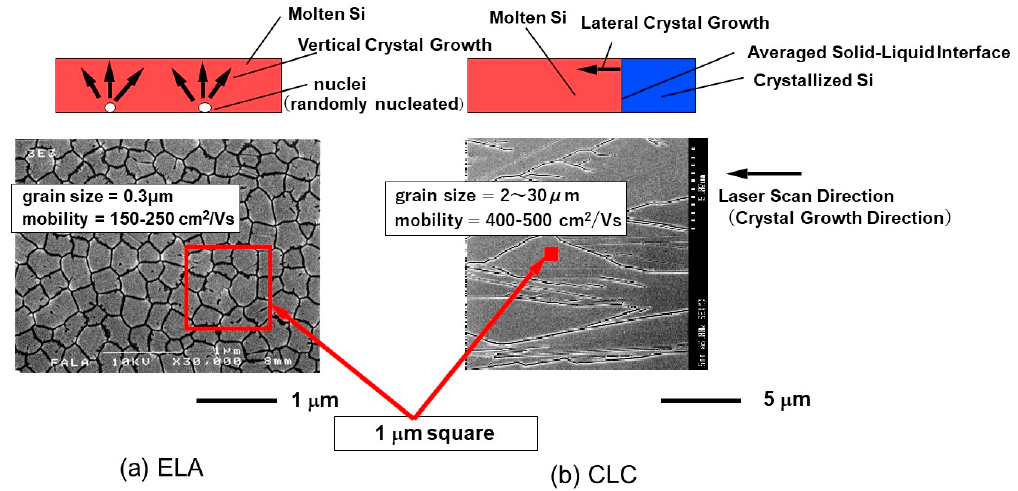
Figure 3. SEM pictures after the delineation of grain boundaries by Secco etching. Crystal growth directions and grain boundary patterns are shown. ( a ) A 400 nm-thick buffer SiO 2 and a successive 45 nm-thick a-Si were deposited by PE-CVD on a glass substrate. ELA was carried out at an energy density of 450 mJ/cm 2 and an irradiation of 20 shots for each point. ( b ) A 400 nm-thick buffer SiO 2 and a successive 150 nm-thick a-Si were deposited on a glass substrate. CLC was carried out at 10 W power and 50 cm / s scanning velocity with an elliptical line beam. Beam size was 400 µ m × 20 µ m.